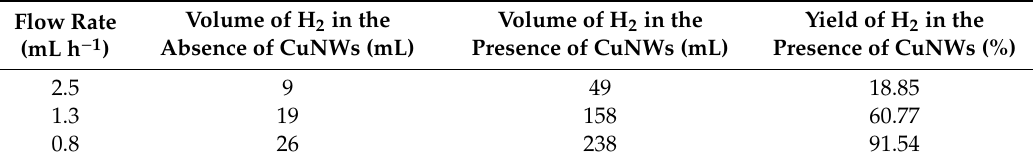
Table 4. Total volume and yield of H 2 produced with di ff erent flow rates (with and without CuNWs). Flow